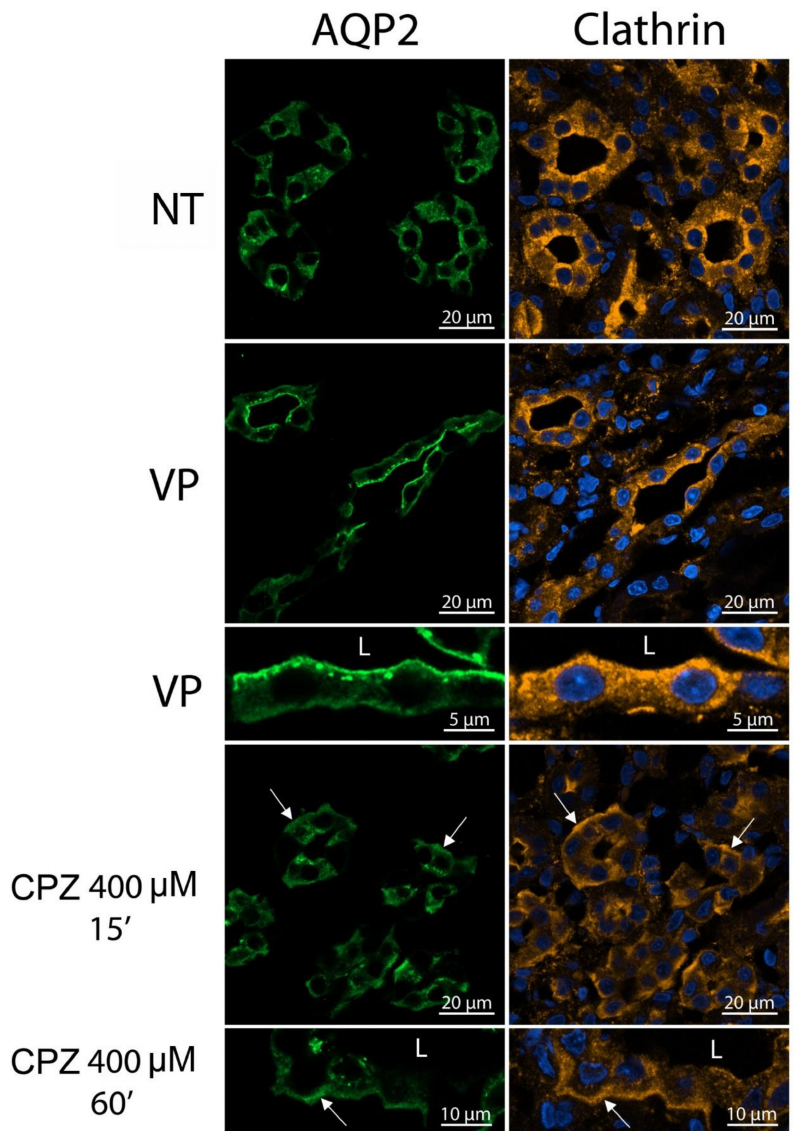
Figure 4. CPZ a ff ects both clathrin and AQP2 subcellular distribution in rat kidney slices. Rat kidney slices were incubated with or without CPZ (400 µ M for 15 min), and then, AQP2 and clathrin were immunolocalized. To test cell viability, some slices were treated with vasopressin (AVP, 100 nM for 10 min). After AVP treatment, the apical AQP2 signal was greatly increased in principal cells, with increased apical clathrin signals also (middle panels). In contrast, after CPZ treatment, the basolateral AQP2 signal was markedly increased along with the basolateral clathrin signal (lower